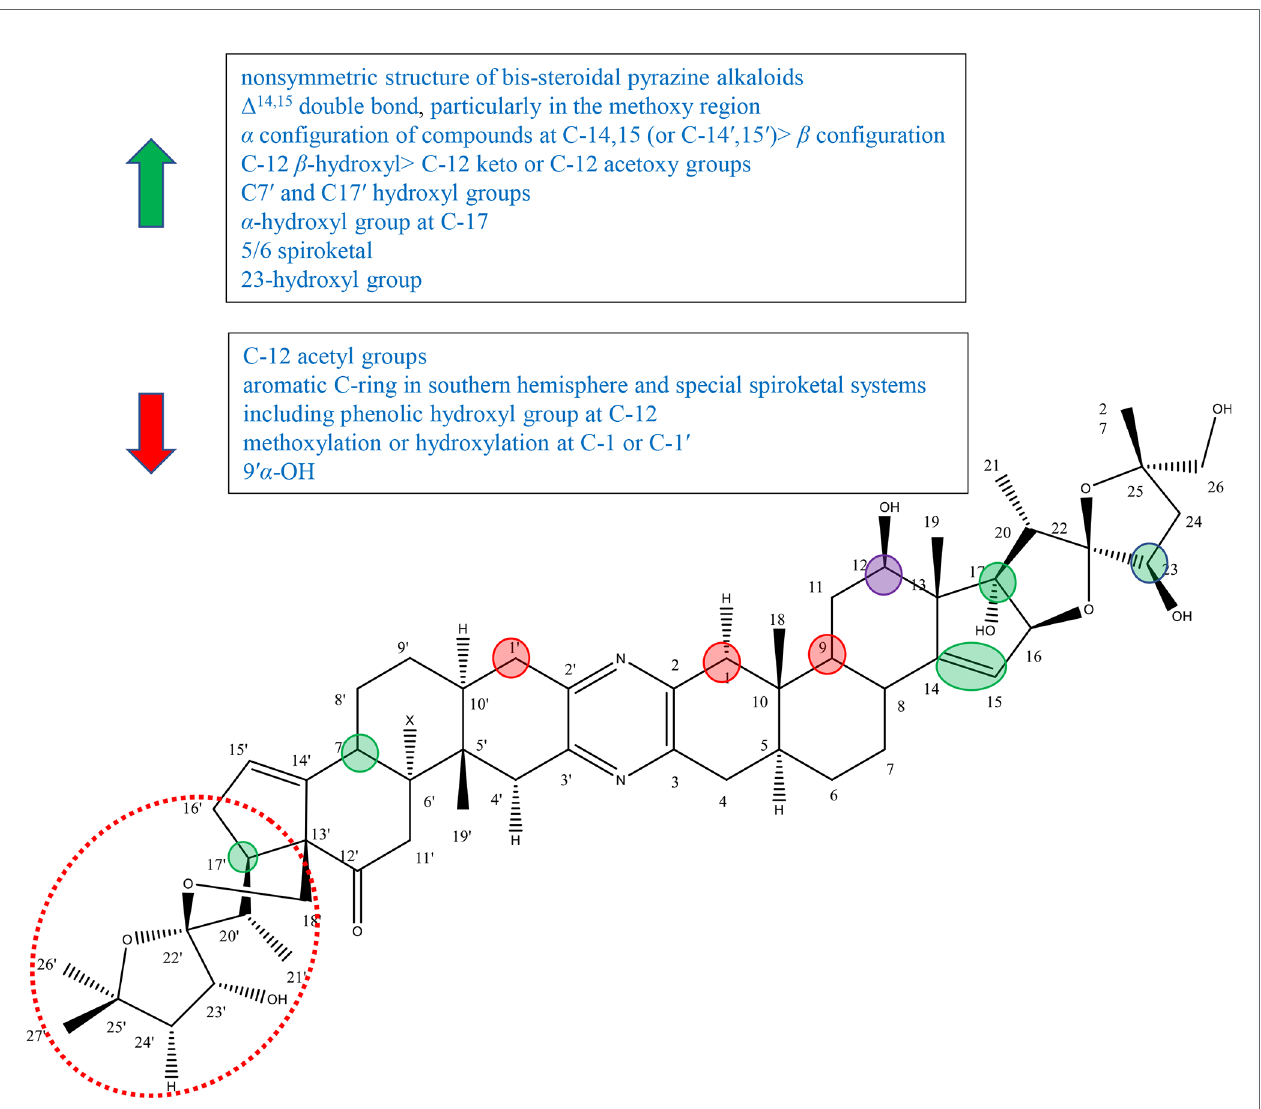
FIGURE 8 | Summary of Structure-activity Relationship of Bis-steroidal Pyrazine